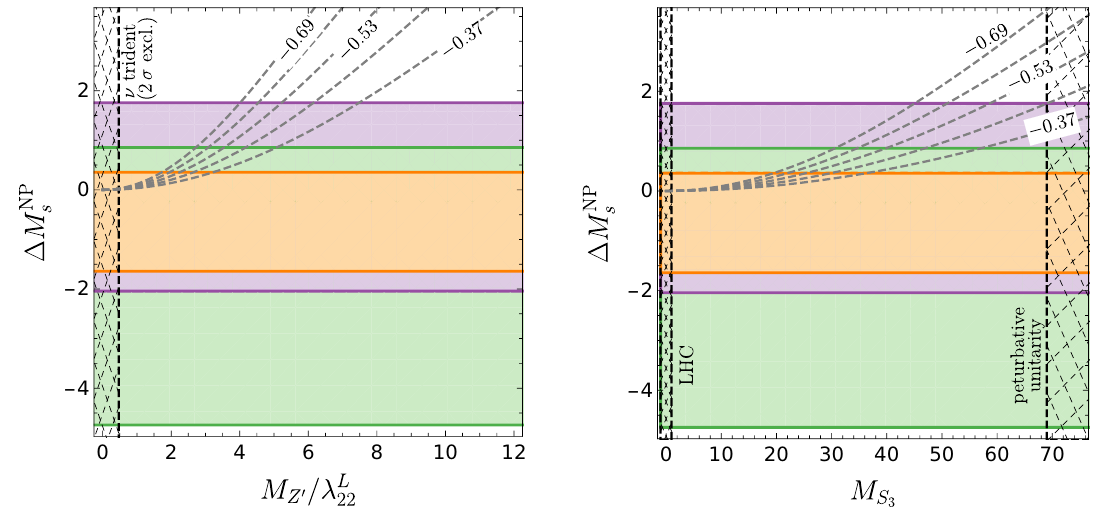
(dashed lines) for various values of s